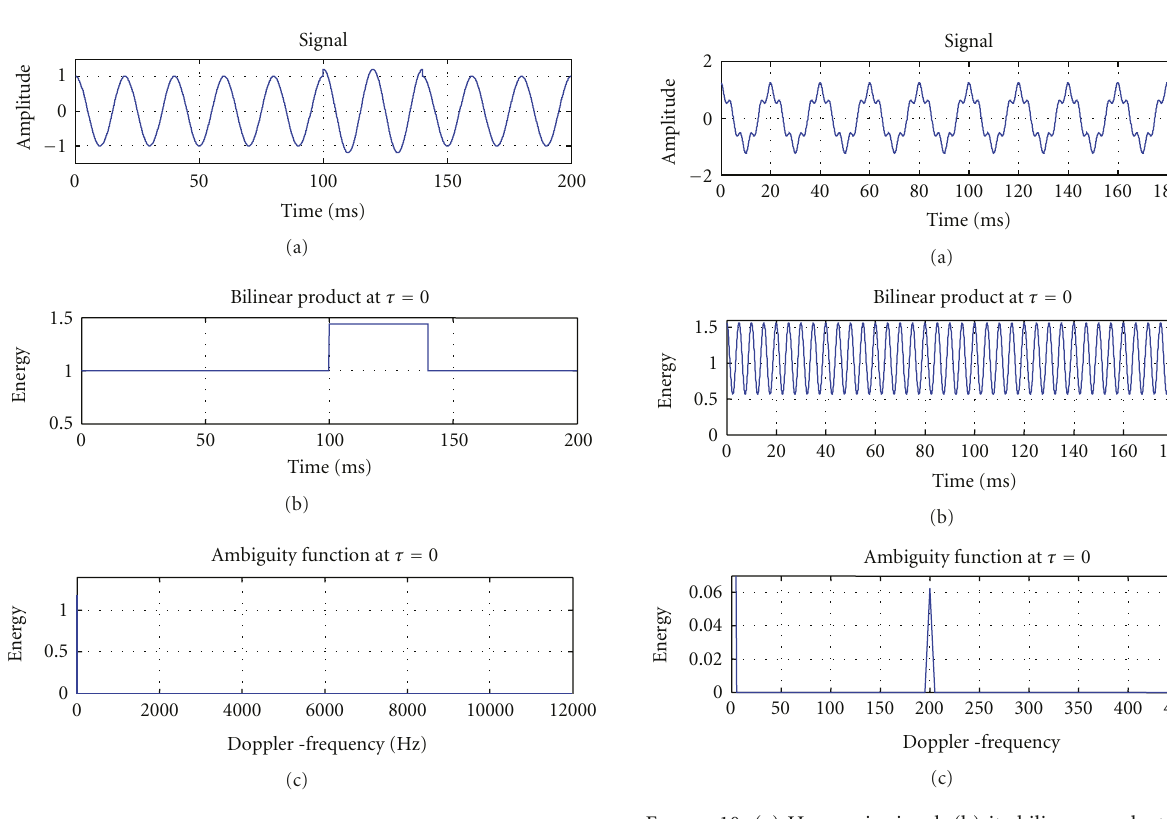
Figure 9: (a)Swell signal,(b) its bilinear product, and (c)ambiguity function at τ = 0.